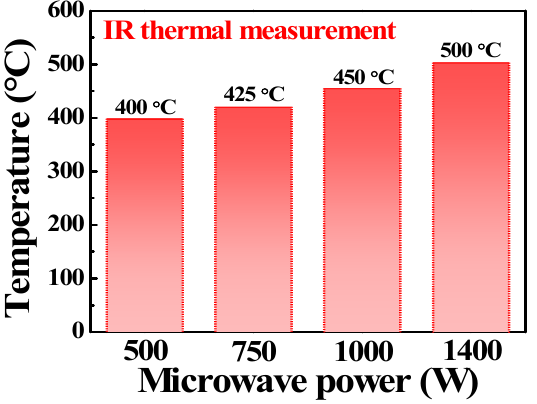
Figure 2. Variation in the temperature of ITO-coated glass substrate with microwave power.